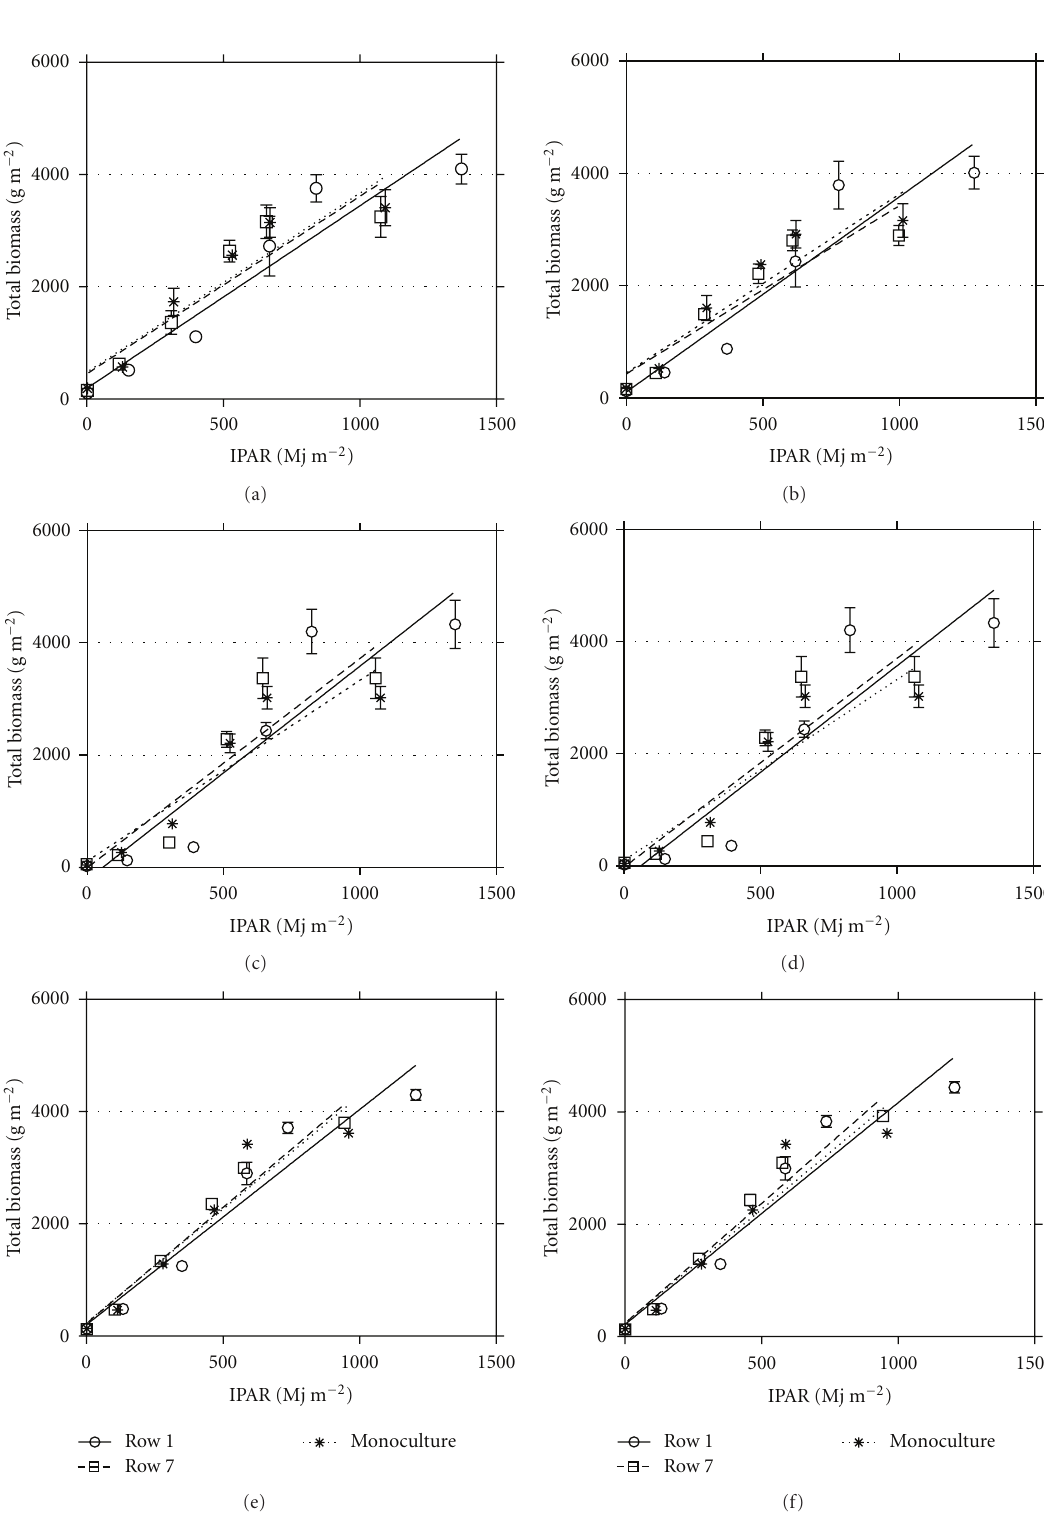
Figure 3: Total biomass versus IPAR in rows 1 (border) and 7 (center) in the strips and in monoculture, during C1 (a, b), C2 (c, d), and C3 (e, f). (a), (c), and (e) correspond to corn-soybeans MG III, and (b), (d), and (f) to corn-soybeans MG